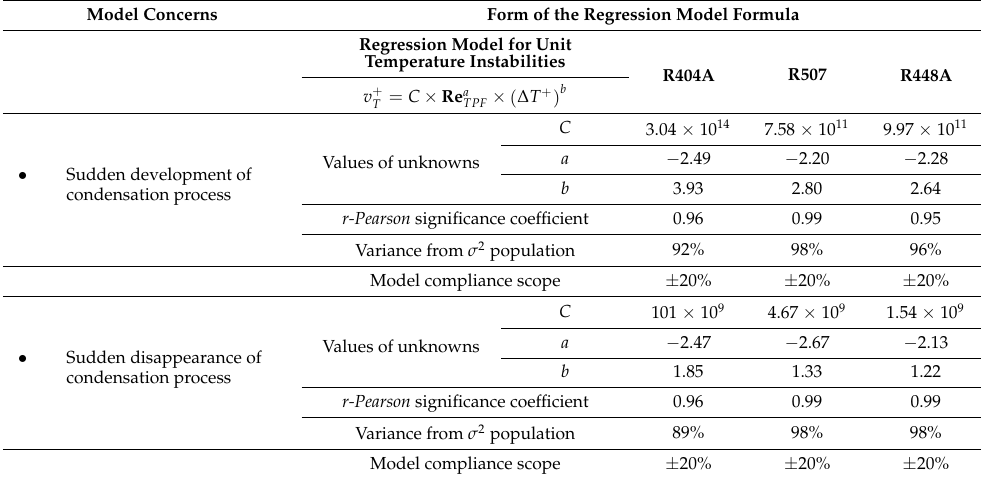
Table 3. Values for the regression model of temperature